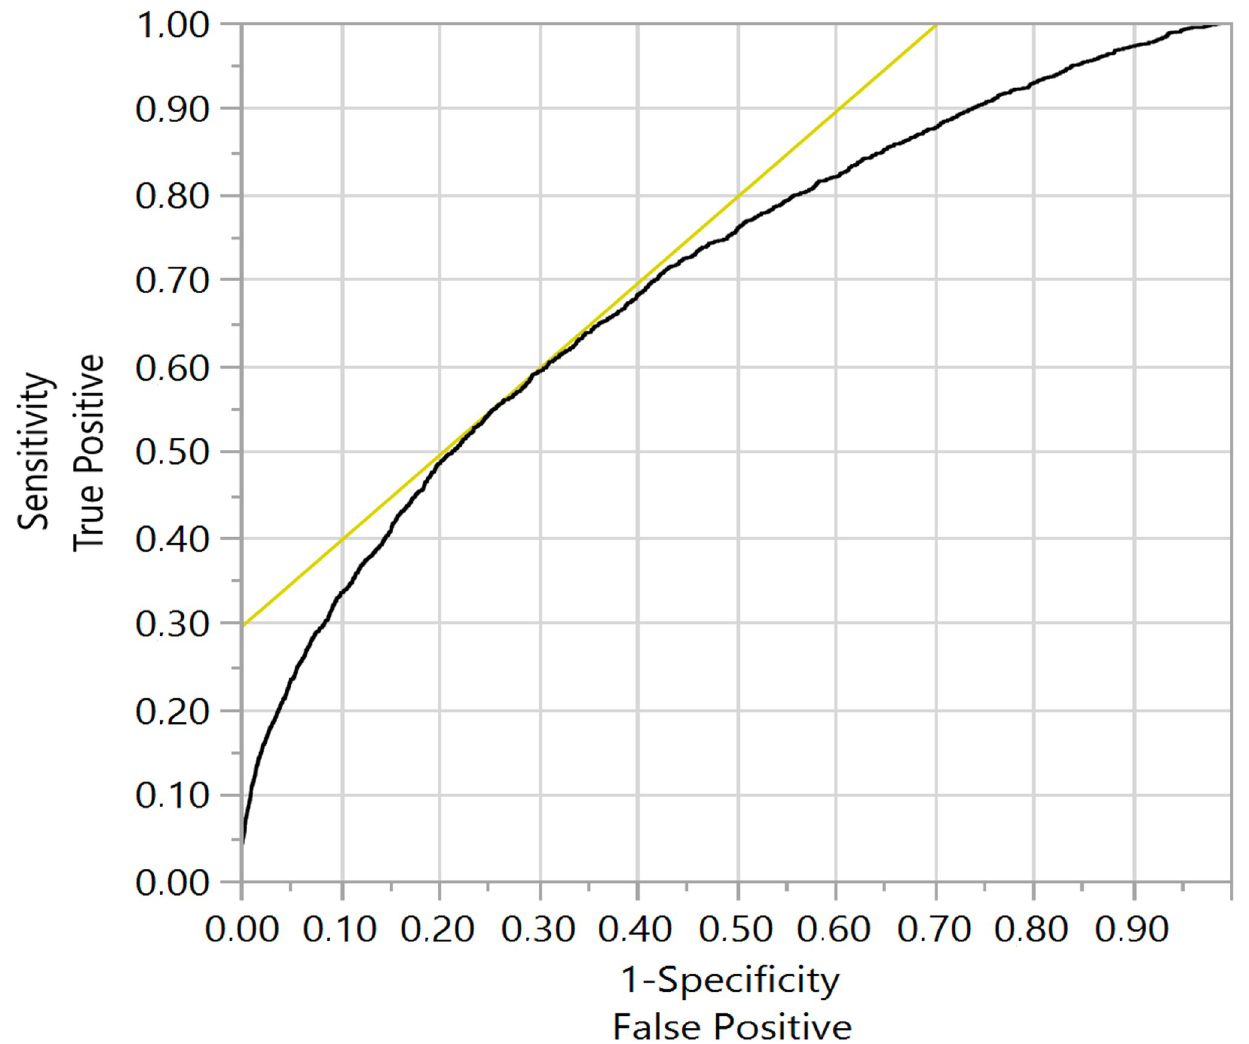
Fig 2. Receiver operating characteristics. Using STEMI MINOCA—1 vs. STEMI MI-CAD + PCI– 0 = ’1’ to be the positive level. Area under the curve— 0.7.